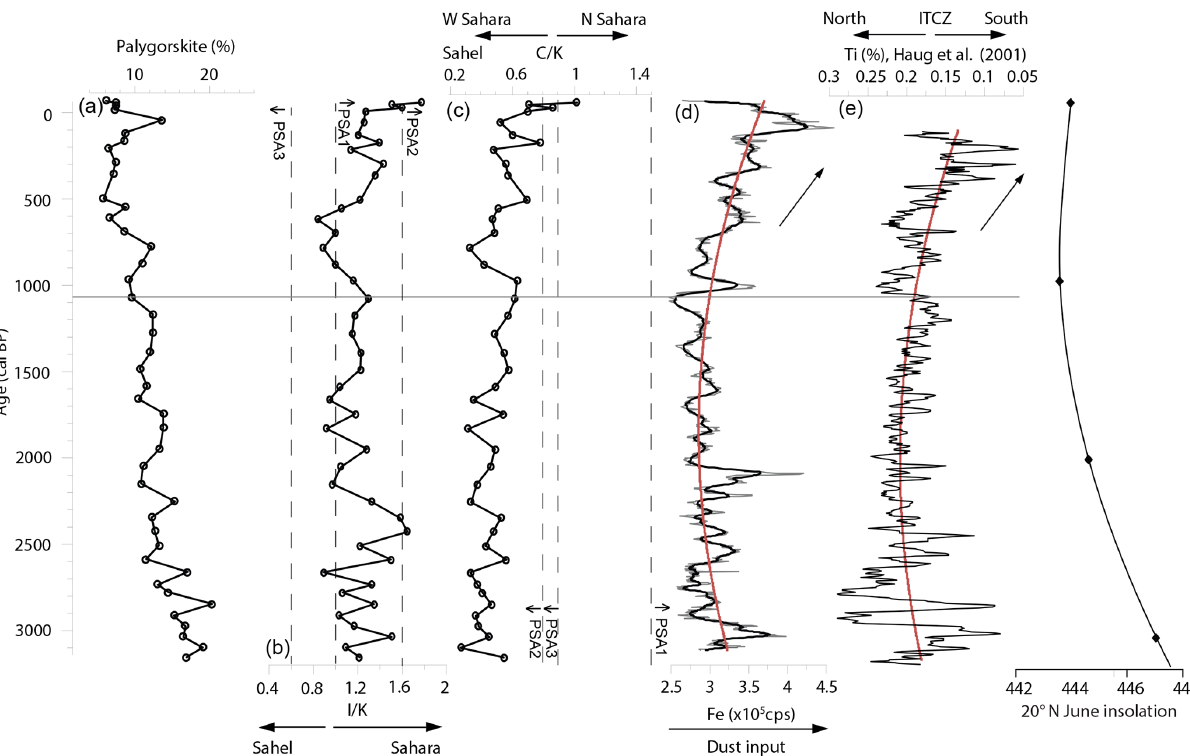
Figure 4. (a) Palygorskite content (%). (b) I / K (illite to kaolinite) ratio to discriminate the source area of the Sahel (PSA3) from the Sahara (PSA1 and PSA2). (c) C / K (chlorite to kaolinite) ratio to discriminate source areas in the northern Sahara (PSA1) from the western Sahara (PSA2). Vertical dashed lines represent the upper and lower boundary of African sources. (d) Fe content interpreted as total dust input. (e) Variation of the ITCZ position (Haug et al., 2001) with reverse scale. (f) 20 ◦ N June insolation from Berger and Loutre (1991). Red curves present the long-term trend, and black arrows indicate a common variation. The horizontal gray line at 1071calBP represents this break-point analysis on the linear regression model between Fe content (dust input) and the